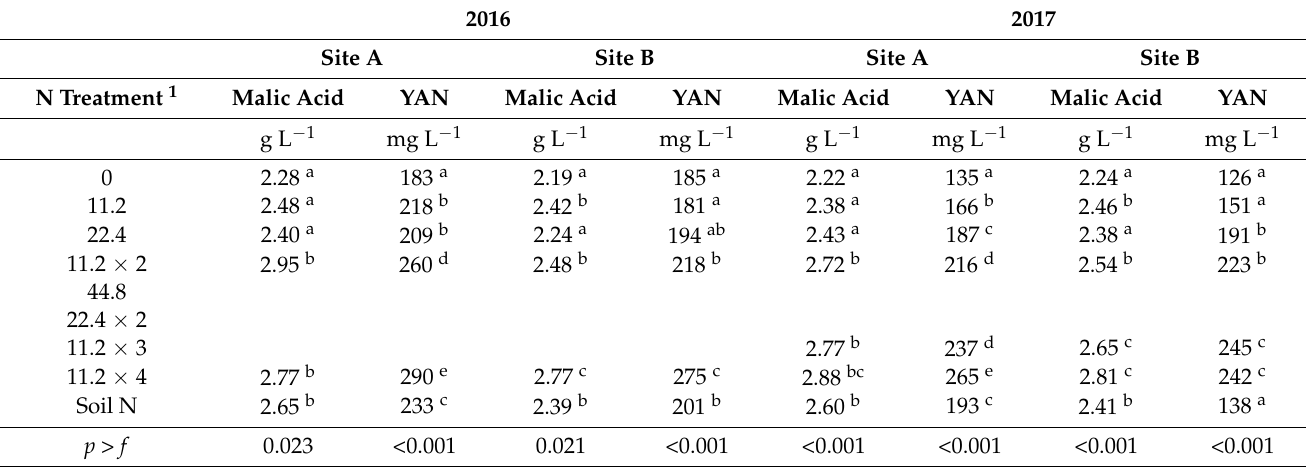
Table 5. Foliar and soil applied N effects on wine grape quality parameters in 2016–2017 1